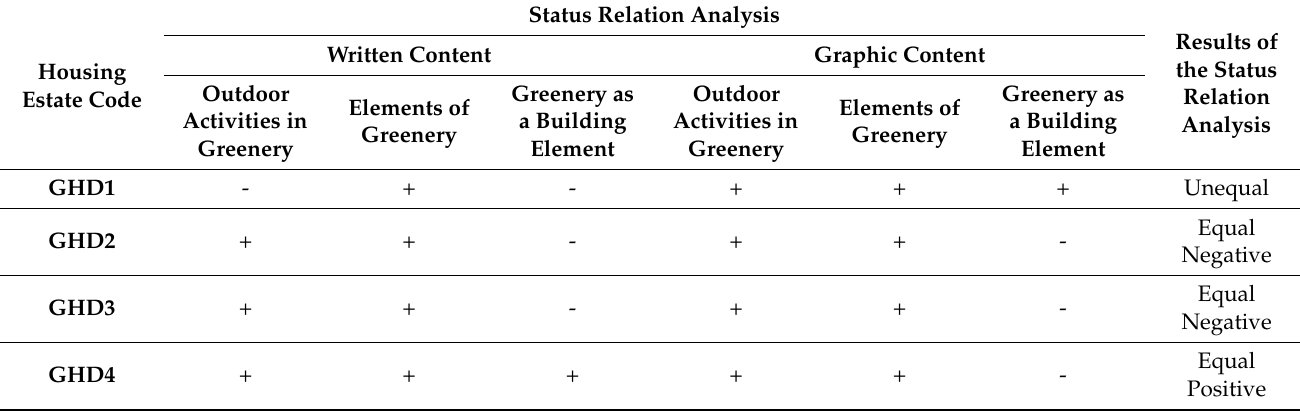
Table 8. The status relations analysis between the written and graphic content of GHDs’ advertising websites regarding the three thematic categories: outdoor activities in greenery, elements of greenery, and greenery as a building element. (+ the presence of the indicator in the website content; - the absence of an indicator in the website